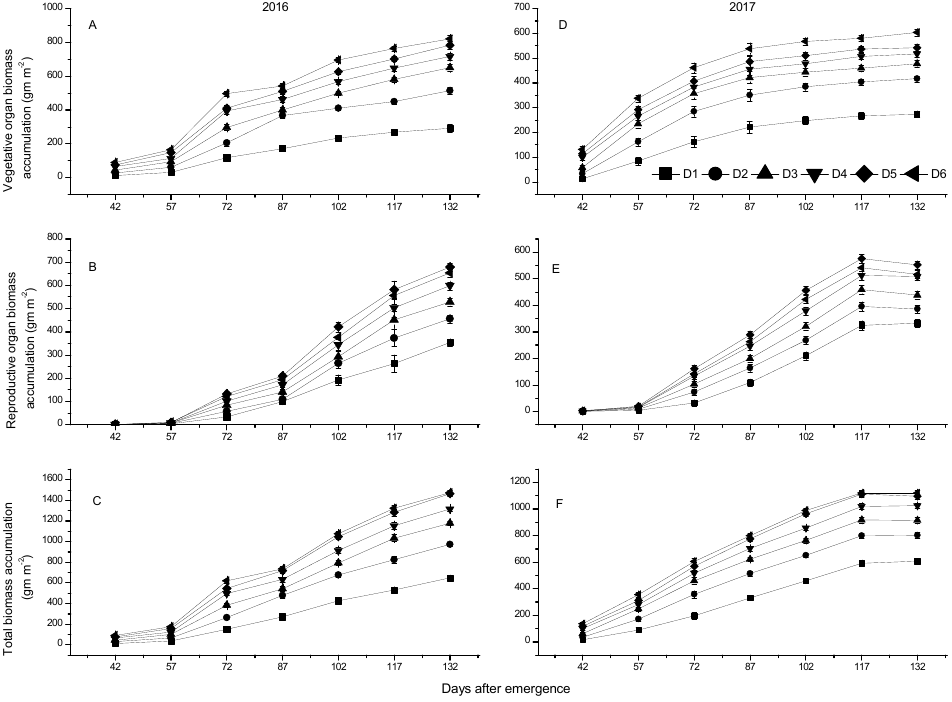
Figure 2. Vegetative organ biomass accumulation ( A , D ), reproductive organ biomass accumulation ( B , E ), and total organ biomass accumulation ( C , F ) of 2016 and 2017 cotton growing seasons.